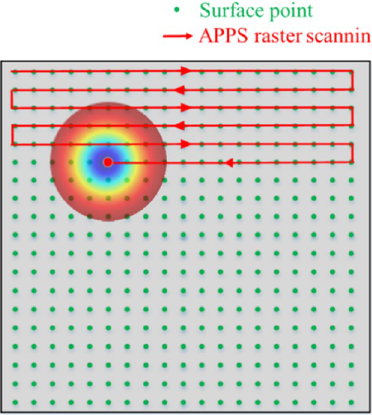
Figure 15. Schematic of continuous APPS mode.